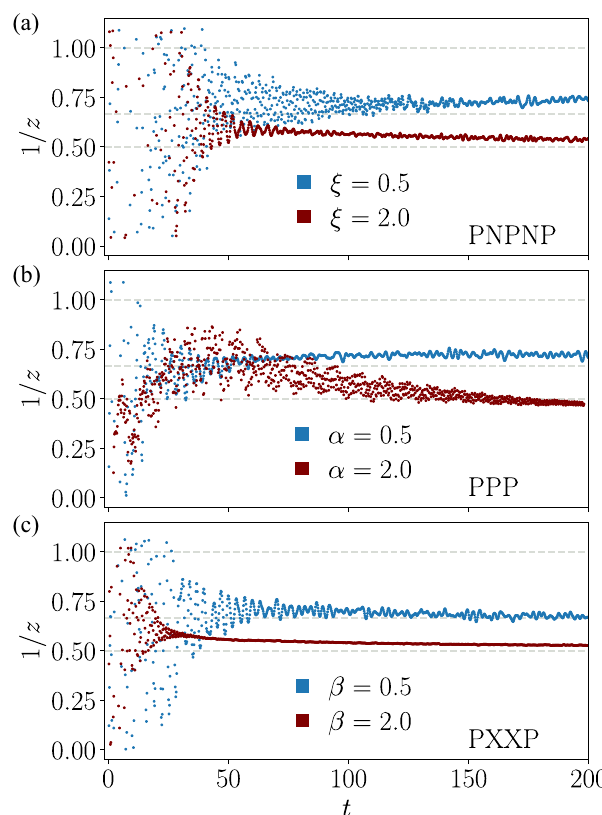
FIG. 11. Instantaneous transport exponent for PNPNP, PPP, and PXXP [panels (a), (b), and (c), respectively] at deformation parameters 0.5 and 2.0. In all cases, we observe superdiffusive transport across all accessible timescales for sufficiently weak deformation, while stronger deformations push the dynamical exponent toward the diffusive value. Data for PNPNP and PPP are obtained with bond dimension χ ¼ 256 and data for PXXP are obtained with bond dimension χ ¼ 192 . All data were obtained with N ¼ 512 .